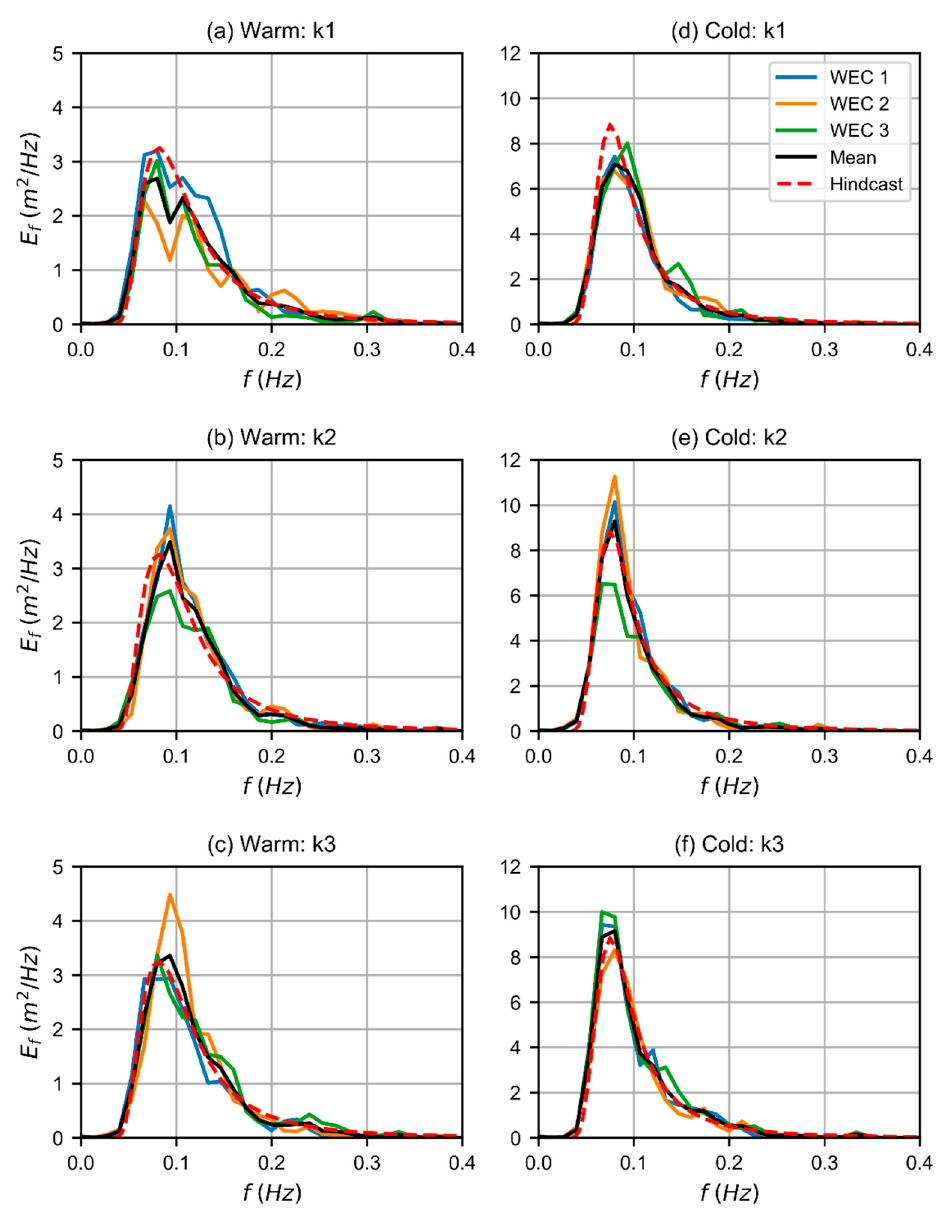
Figure 6. Spectra derived from FUNWAVE time series at select WEC locations, corresponding to all three realizations of ( a – c ) warm months and ( d – f ) cold months. The mean spectra of WECs 1–3 are also shown in each panel, as well as the hindcast spectra for each climate.